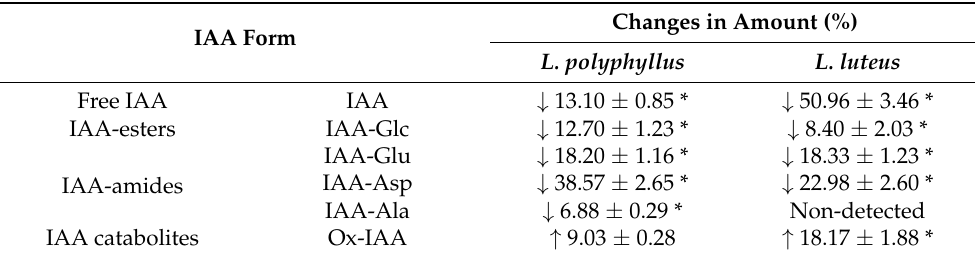
Table 2. The comparison of IAA content in cotyledons of four-day-old seedlings of two lupine species grown at 25 ◦ C versus 30 ◦ C.